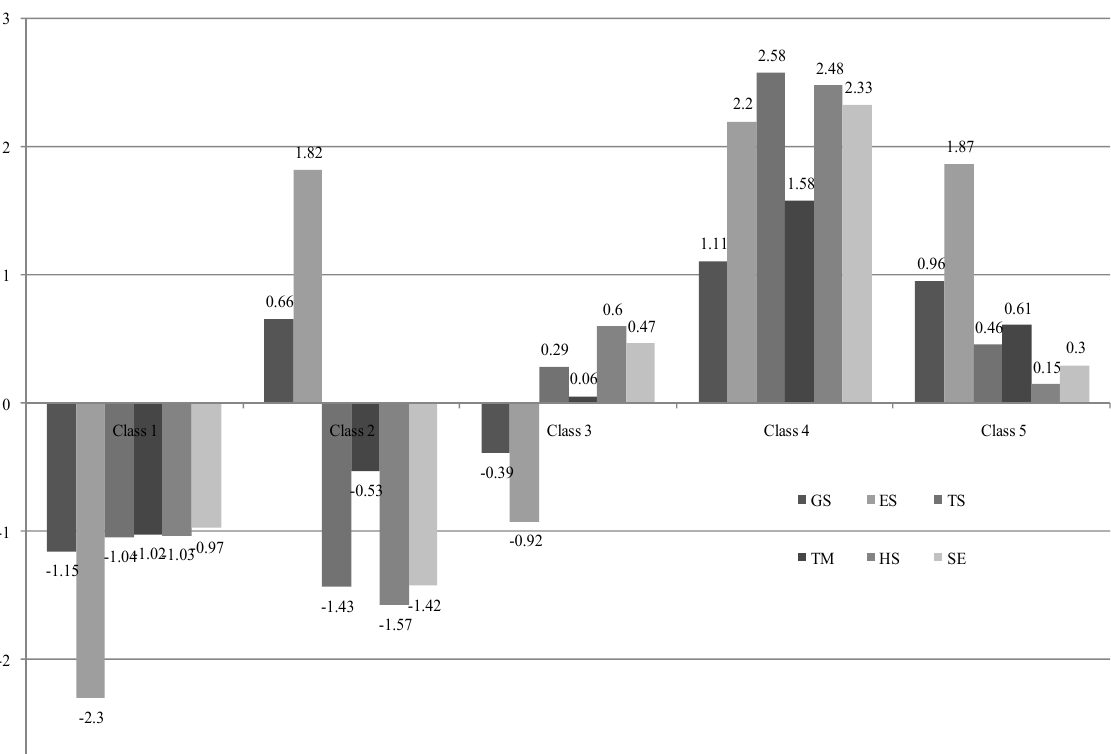
Figure 1 . Study 1 standardized subscale means by